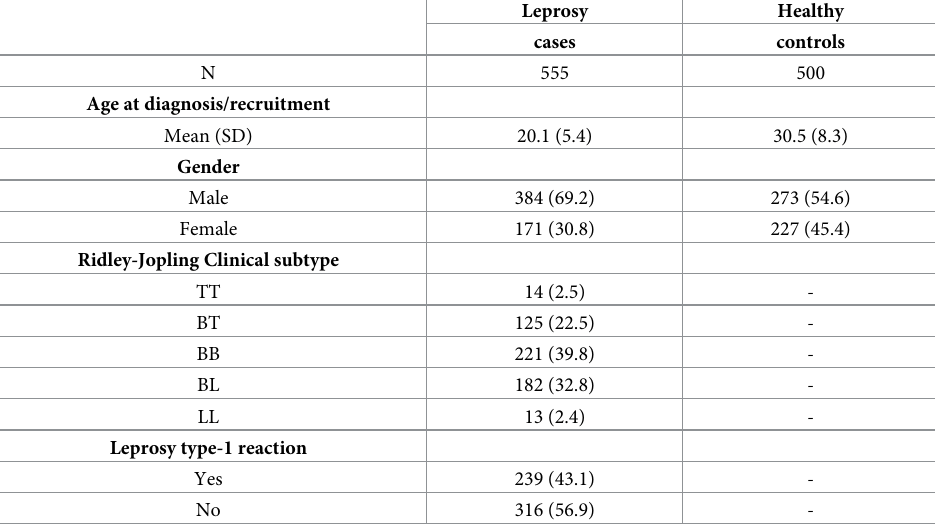
Table 1. Studied population